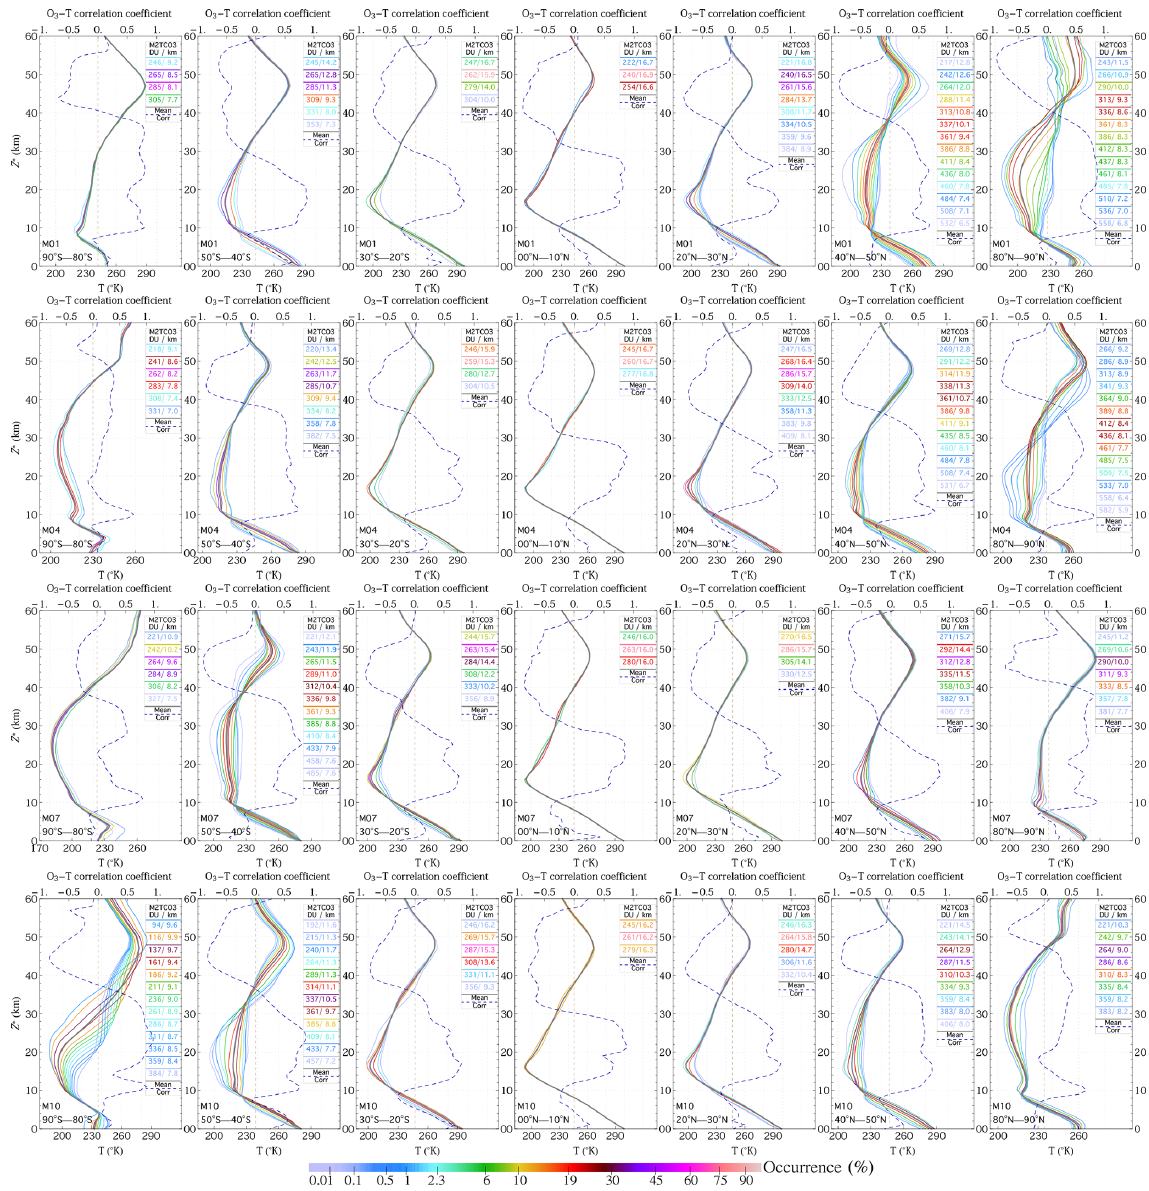
Figure 10. Climatological temperature profiles corresponding to the M2TCO3 O 3 profiles shown in Fig. 6. The color of a solid line indicates the percentage occurrence of the climatological profile, and its line legend displays the average tropopause altitude and the average total column O 3 . The solid gray line represents the monthly zonal mean temperature profile, and the dashed dark blue line shows the coefficient of correlation between O 3 partial pressure and temperature as a function of pressure altitude Z ∗